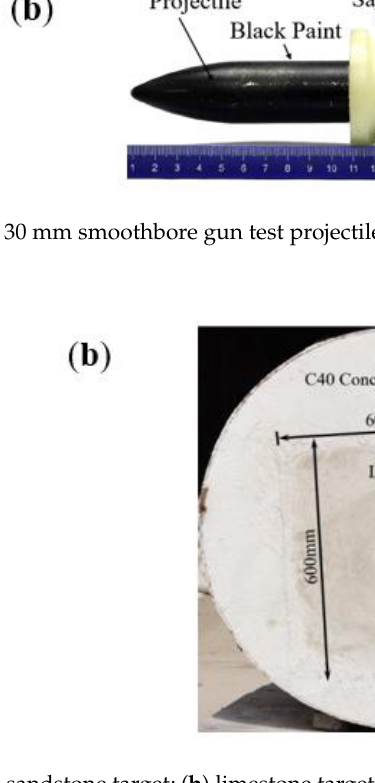
Figure 3. Test target: ( a ) red sandstone target; ( b ) limestone target. Table 4. Test scheme. Table 3. Steel composition for